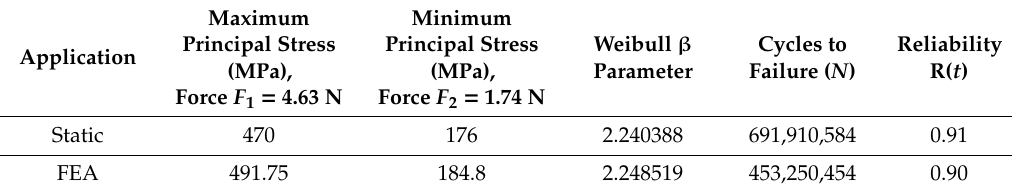
Table 6. Summary of the comparison between the analytical static method and FEA simulation